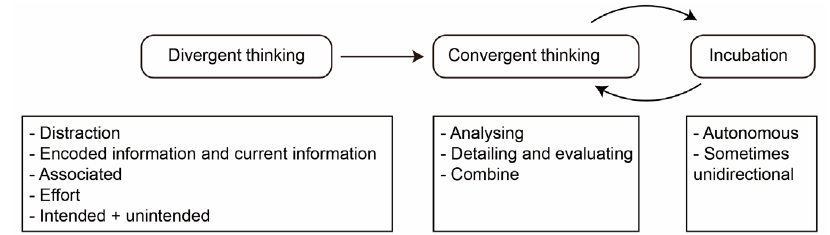
Figure 6. Structure of intellect model.